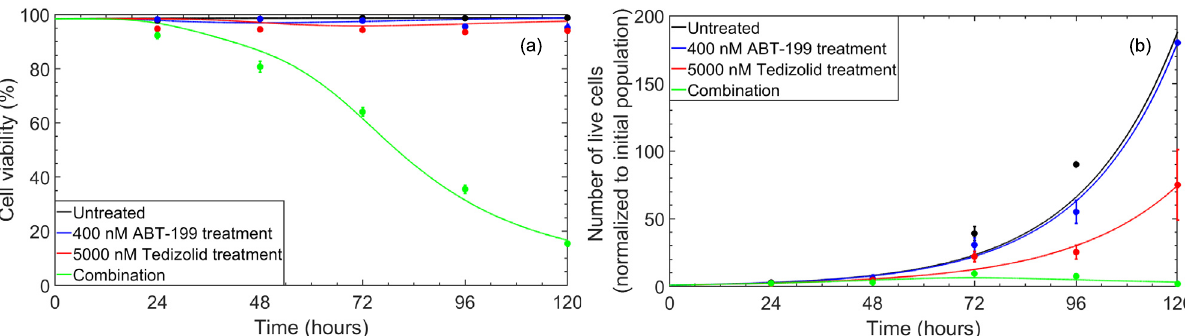
Fig 4. Cellular viability (a) and live cell population (b) in untreated and treated MOLM-13 R2 cells. Solid lines show the results of the mathematical model, while data points correspond to the average of experimental measurements over the five-day window. Error bars correspond to one standard deviation obtained from experimental